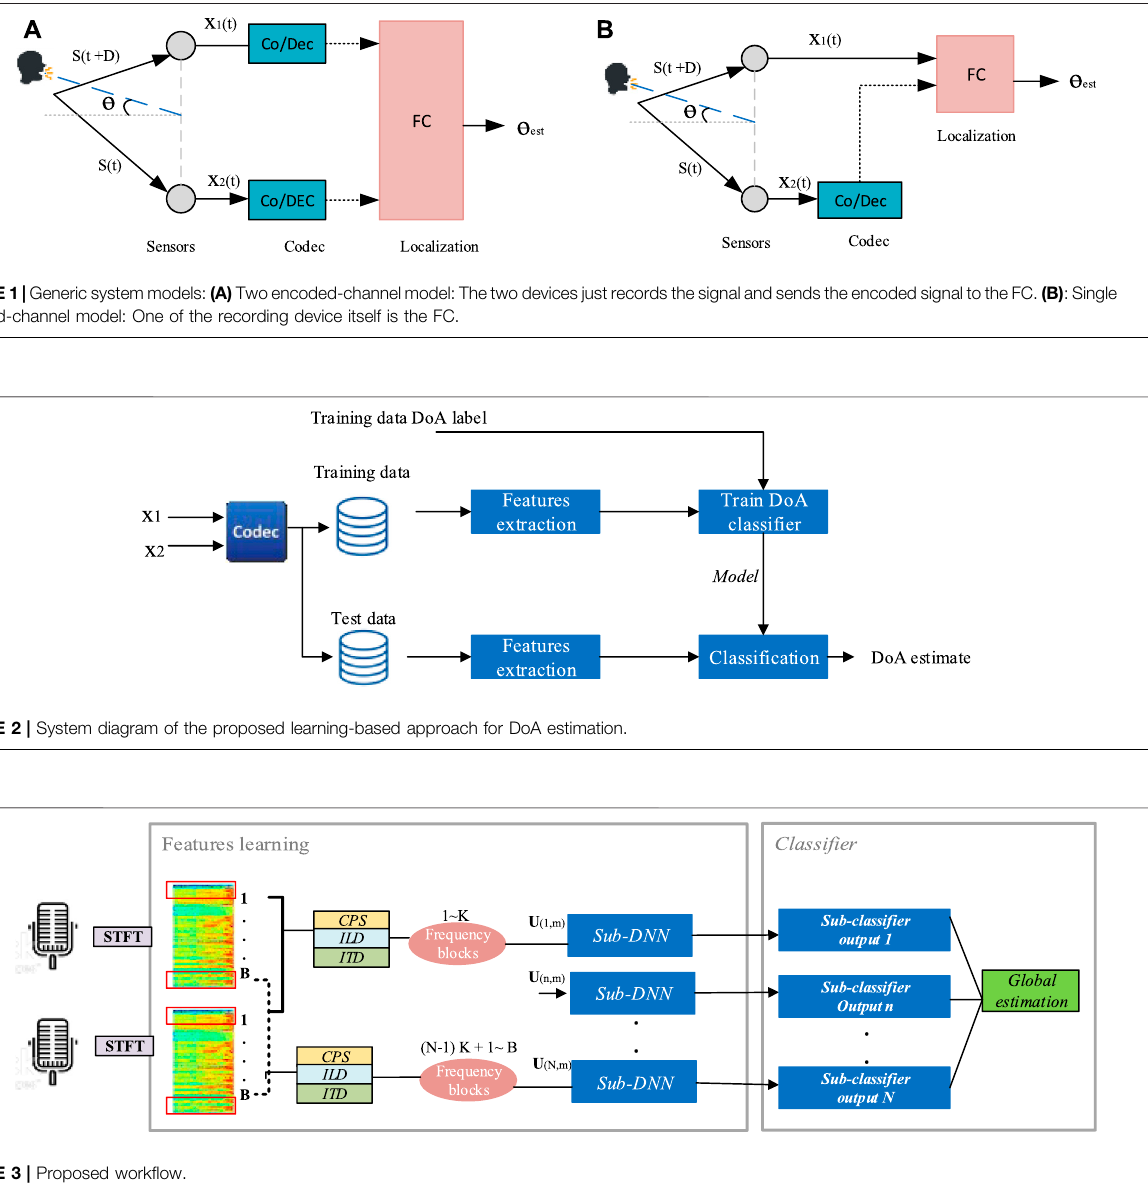
FIGURE 3 | Proposed work fl